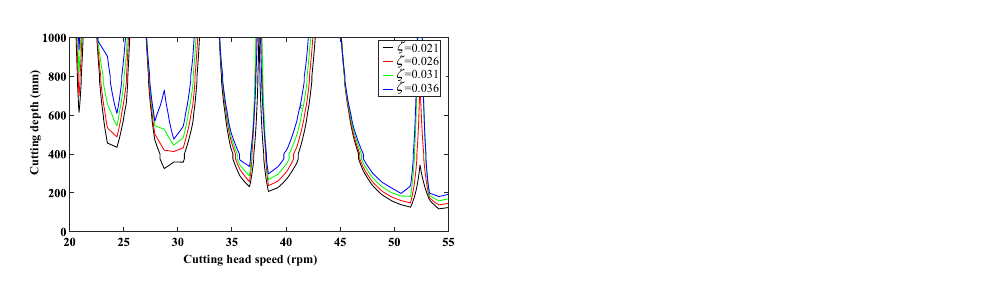
Figure 11. Stability curve of cutting system with different modal stiffness.